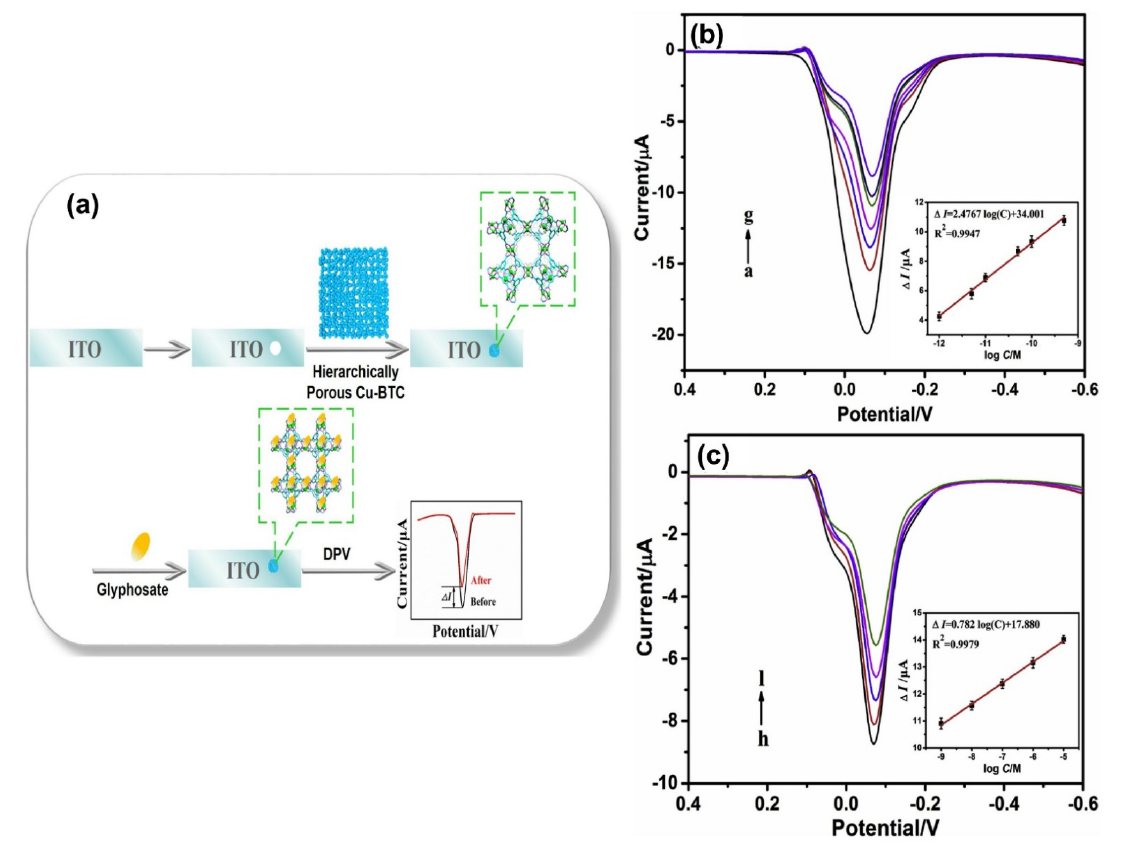
Figure 24. ( a ) Analytical principle of the electrochemical sensor based on the hierarchically porous Cu-BTC MOF material. ( b ) Differential pulse stripping voltammograms of Cu-BTC/ITO at different GLYP concentrations from a to g (0, 1.0 × 10 −6 , 5.0 × 10 −6 , 1.0 × 10 − 5 , 5.0 × 10 − 5 , 1.0 × 10 − 4 , 5.0 × 10 − 4 . ( c ) from h to l (1.0 × 10 −3 , 1.0 × 10 −2 , 1.0 × 10 −1 , 1.0, 0.1 µM). Reprinted with permission from [73]. Copy- right 2019 Elsevier.